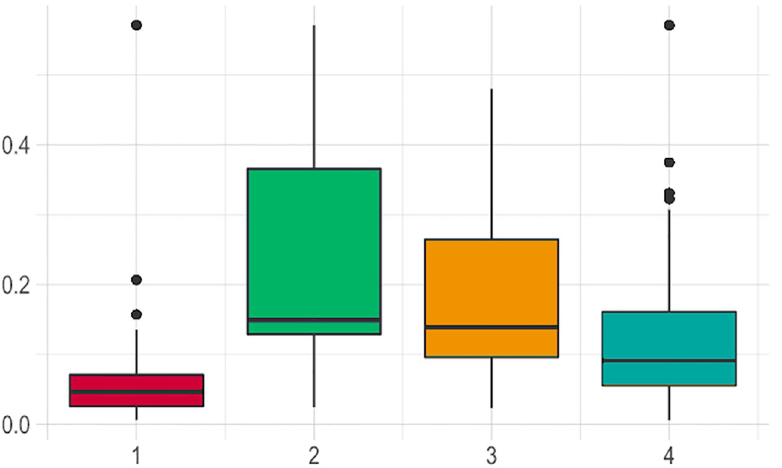
Fig 6. Margay density estimates in the four sampled areas for which estimation was possible (individuals per 100 km 2 ). Each session corresponds to a sampling area: 1) Banhado dos Pachecos Wildlife Refuge (BPWR), 2) Pro´-Mata Center for Research and Conservation of Nature (PROMATA), 3) Teutoˆnia (TEUT), 4) Passo Fundo National Forest (PFNF). The length of each box shows the range within the upper and lower quartile density estimates values, and the vertical lines shows the estimated maximum and minimum density values. The median is represented by horizontal bar inside each box. The black dots represent outliers.